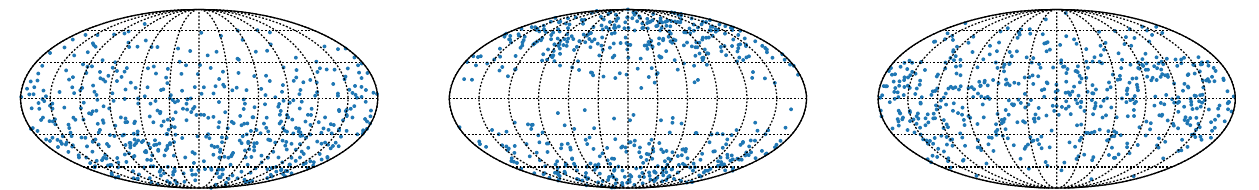
Fig. 18 Coordinatesgeneratedforthreesyntheticdatasets.Theprobabilitydensityfunctionsofthecoordinatedensityareproportionalto1 − sin ( b ) , sin 2 ( b ) and cos 2 ( b ) , respectively